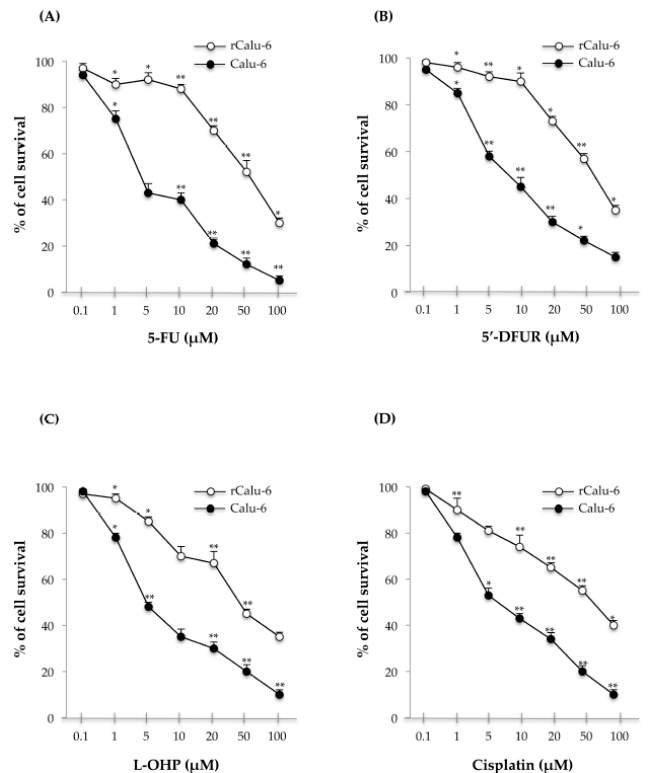
Figure 1. In vitro sensitivity of Calu-6 and rCalu-6 cells to 5-Fluorouracil (5-FU), 5 ′ -Deoxy-5-fluorouridine (5 ′ -DFUR), Oxaliplatin (L-OHP), and Cisplatin. Cells were cultured with increasing concentrations of 5-FU for 48 h and cell growth was assessed by sulforhodamine B (SRB) colorimetric assay. Cell growth was expressed as the percentage of control for each time point. ** p < 0.01, * p < 0.05 vs. untreated cells. The results illustrated in Figures 1–5 are representative of three independently performed experiments; error bars represent the standard deviation. Table 1. Antiproliferative effect of anticancer drugs on Calu-6 and rCalu-6 cells. The tesistance index (RI) is reported as IC 50 rCalu-6/IC 50